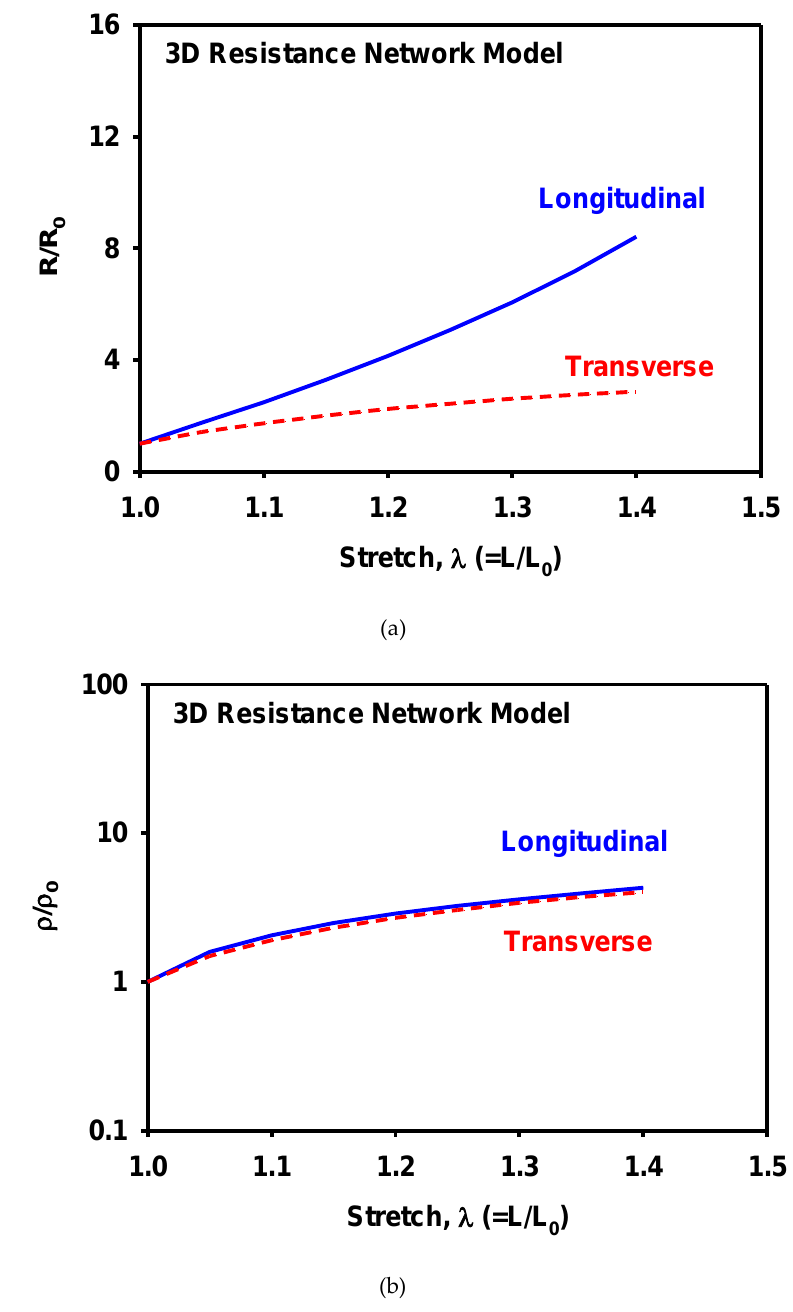
Figure 13. Variation of ( a ) normalized resistance, and ( b ) normalized resistivity with respect to stretch as calculated by the 3D resistance network model.